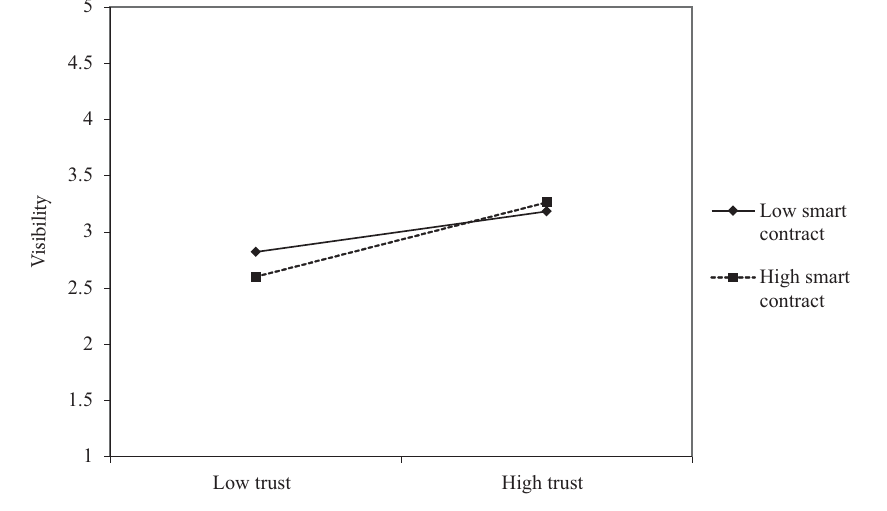
Figure 2. Test result for moderation